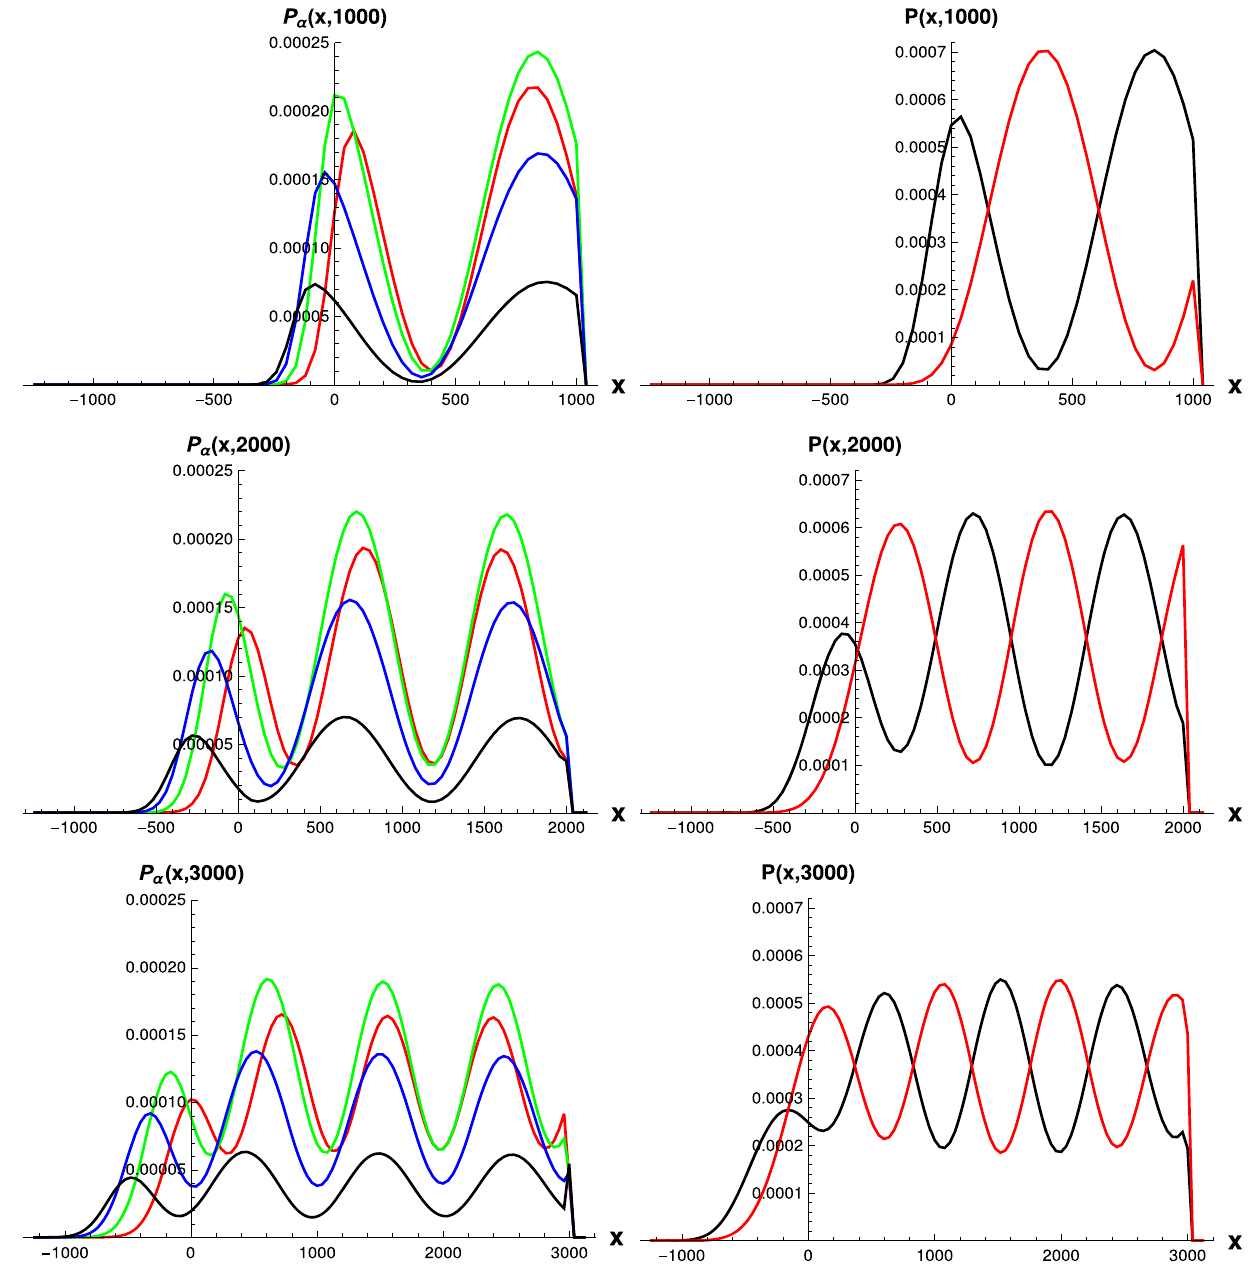
Fig. 10 The probability densities P (right, black) and the partial prob- ability densities P α (left) at t = 1000 (top), t = 2000 (middle) and t = 3000 (bottom). The red curve in the right panels is the appearance probability density P app . The environmental interaction energy eigen-